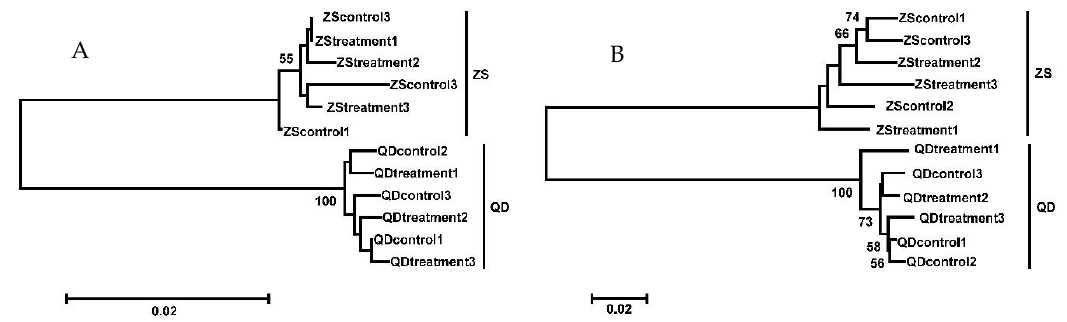
Figure 2. Neighbor-Joining (NJ) tree of the Cytochrome oxidase subunit I ( COI ) ( A ) and the control region ( B ) sequences constructed using the Kimura 2P distance for O. oratoria . QD: Qingdao population; ZS: Zhoushan population.